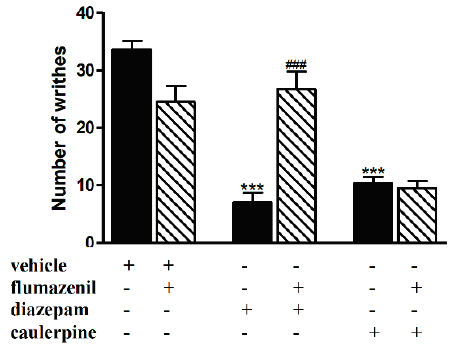
Figure 3. Effect of flumazenil on the antinociceptive effect of caulerpine in the acetic acid model of nociception. Black columns: treatments alone; hatched columns: pretreatment and treatments. The results are expressed as means ± S.E.M. of six animals. (One-way ANOVA followed by Bonferroni’s test). *** p < 0.001 compared to vehicle; ### p < 0.001 compared to